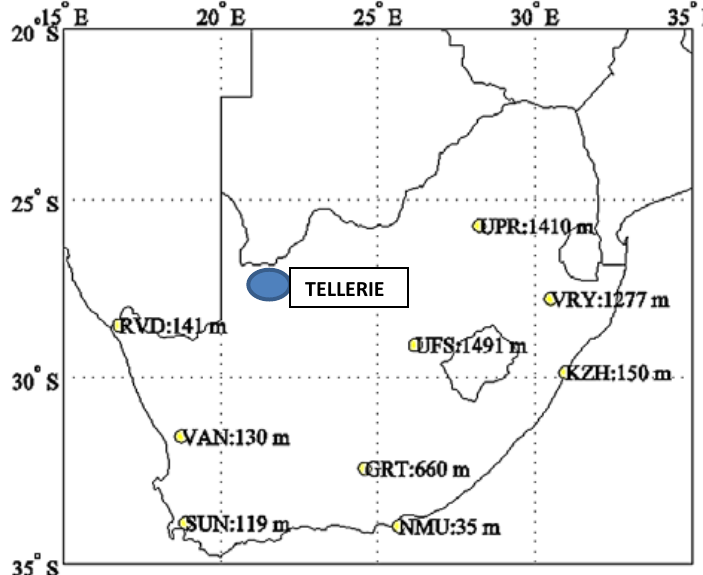
Figure 1. Map of South Africa showing the location of the Eskom solar measuring station Tellerie located in Northern Cape